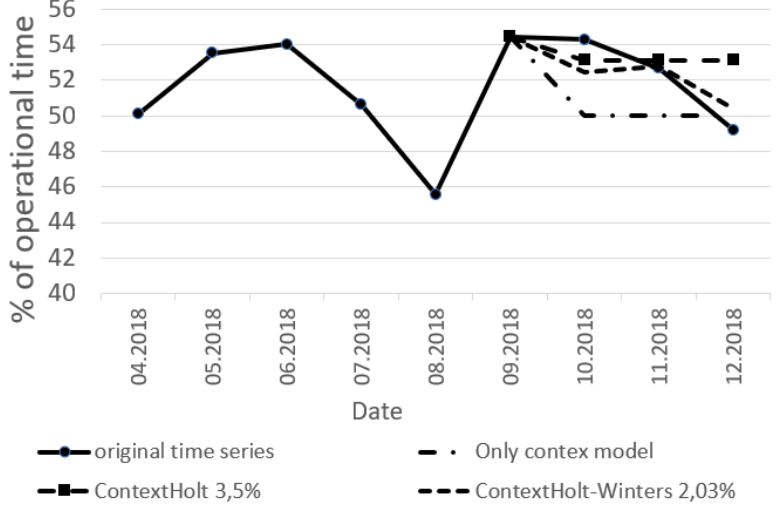
Figure 7. Forecast of % of operational time of department with using of contextual